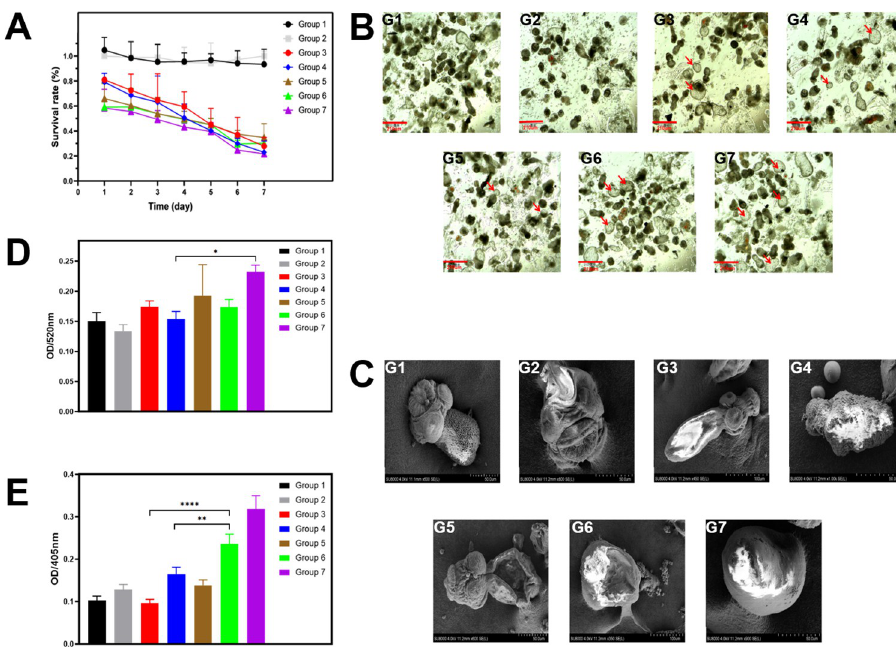
Fig 5. In vitro study on the anti-PSC effect of ABZ-BA. (A) In vitro survival rate of PSCs (n = 3). (B) Representative OM images of PSCs after treatment with different formulations for 5 days (red marked as dead PSC). (C) Representative OM images of PSCs after treatment with different formulations for 5 days. (D) ALP expression level in PSCs culture supernatant. (E) The expression level of caspase 3 in PSCs culture supernatant. ( � : P < 0.05). SPSS 22.0 was used for statistical analysis. Normally distributed measurement data was expressed by x ± s. One-way ANOVA test was used for inter-group comparisons, and Tukey’s t-test was used for multiple comparisons. P < 0.05 means the difference is statistically significant( � p < 0.05, �� p < 0.01).